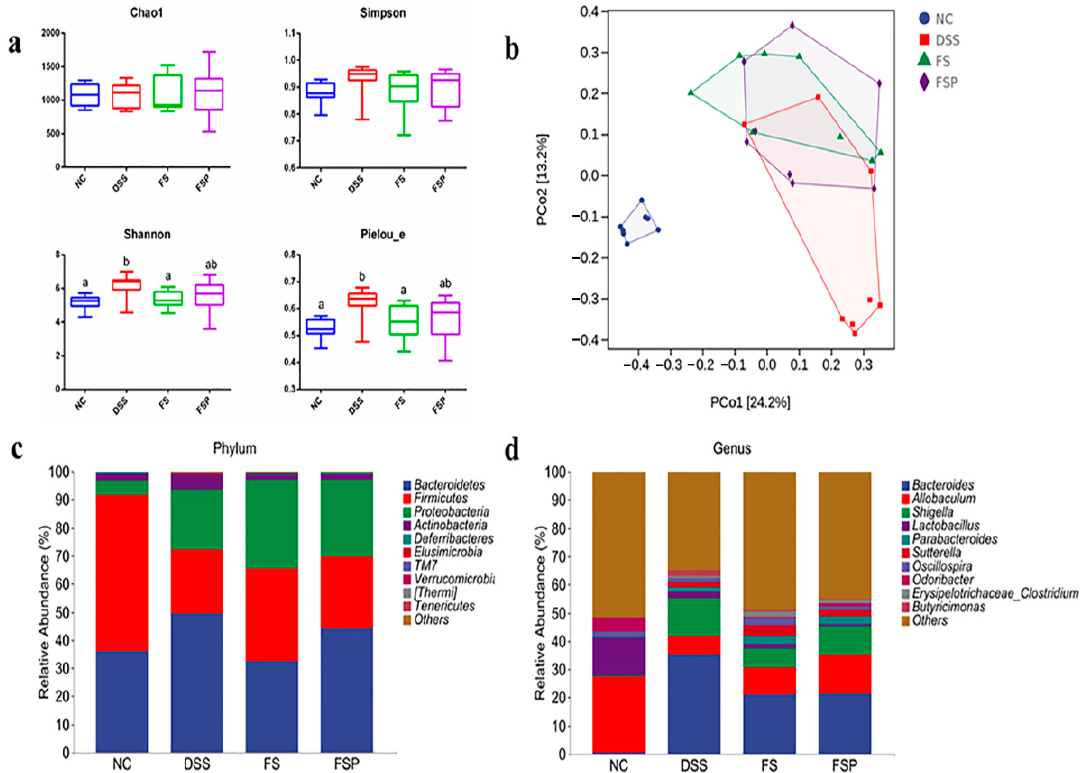
Figure 6. The alpha diversity (Chao1, Shannon, Simpson, and Pielou_e indexes) in different groups ( a ), PCoA plot of unweighted UniFrac distances of beta diversity ( b ), and community bar plots of phylum and genus level ( c , d ). Groups are labeled from smallest to largest in the order of mean value. Mean values with different letters are significantly different ( p < 0.05).